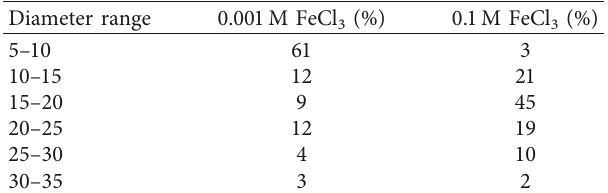
Table 1: Percentage of vZVI produced in relation to the FeCl concentration. Diameter